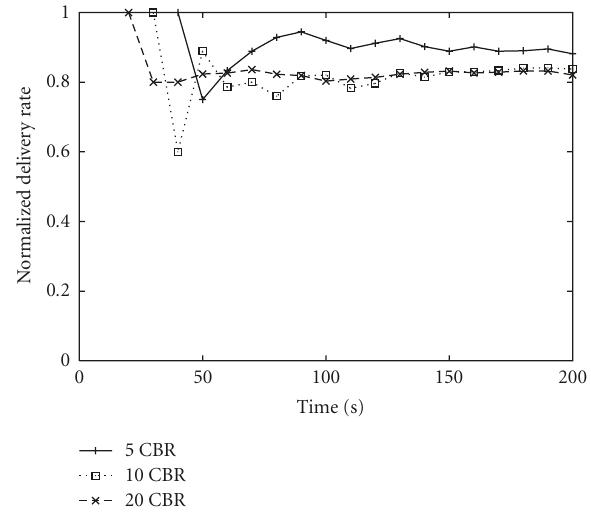
Figure 17: The influence of tra ffi c in AODV performance using the modified bounce rule.